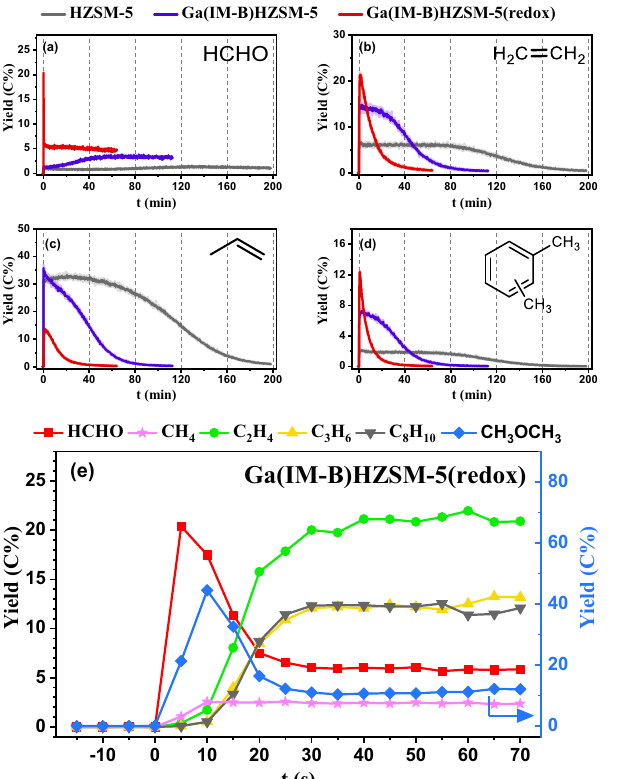
Fig. 3 Product trend after reduction-oxidation treatment of Ga(IM) HZSM-5. The real-time yields (C%) of ( a ) HCHO, ( b ) C 2 H 4 , ( c ) propylene, and ( d ) C 8 aromatics in MTH reaction over parent HZSM-5, Ga(IM-B) HZSM-5 and Ga(IM-B)HZSM-5(redox). e Is an enlarged view of the fi rst 70 s in MTH over Ga(IM-B)HZSM-5(redox). Reaction conditions: 400°C; MeOH WHSV = 12.52 g MeOH g catalyst − 1 h − 1 ; P = 2 Torr; each reaction proceeded until the C 2 H 4 yield dropped to 0.5 C%. The solid line in ( a ) is the original yield curve. In ( b – d ), the original yield curves (transparent solid lines) have been smoothed as bright solid lines. The product yields in the gray dotted box of ( e ) were the fi rst real-time yields of products obtained after methanol feeding.